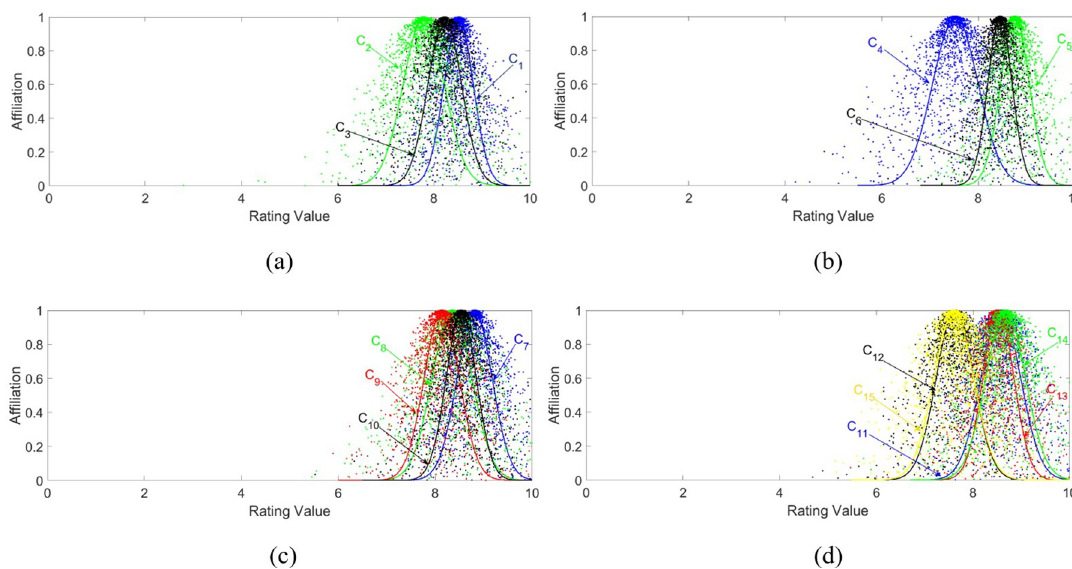
Fig 5. Cloud diagram of second-class indexes. The indexes are placed in cloud diagrams (a), (b), (c) and (d) according to the major categories. (a), (b), (c) and (d) indicate the clouds of noise and vibration, light environment, thermal environment, and human- computer interaction second-class indexes, respectively.